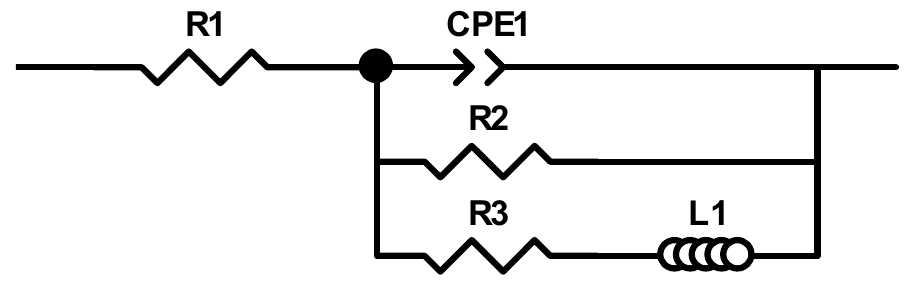
Figure 14. The equivalent circuit used for fitting the experimental electrochemical impedance Table 4. Fitting parameters obtained from the EIS measurements of the Mg 72 Zn 24 Ca 4 alloy immersed in the Ringer solution at 37 ° C up to 24 h.